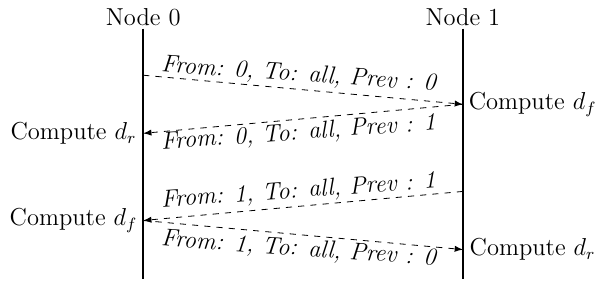
Figure 4. Case of probe